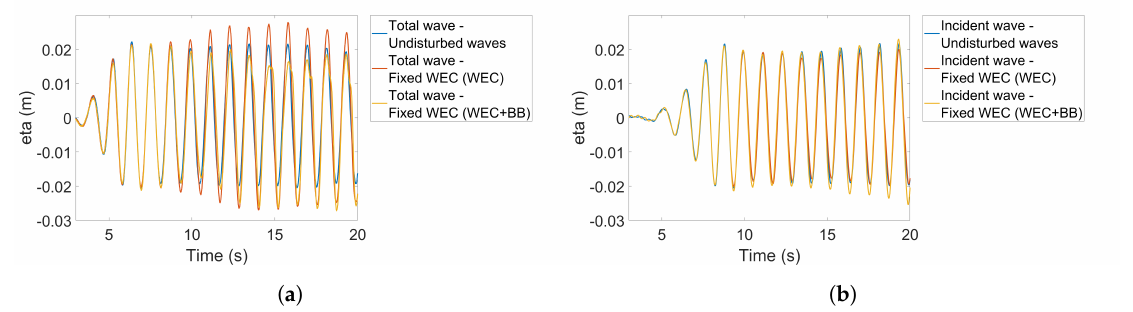
Figure 15. Example of measured data for the same target regular wave simulated during three different experiments (undisturbed waves, fixed WEC and fixed WEC (with bottom box)) and corresponding calculated incident wave for two of these experiments. ( a ) Water surface elevation measured during undistur-bed wave experiments and fixed-WEC experiments for the wave condition R06. ( b ) Calculated incident wave for undisturbed waves and fixed-WEC experiments using WaveLab for the wave condition R06.